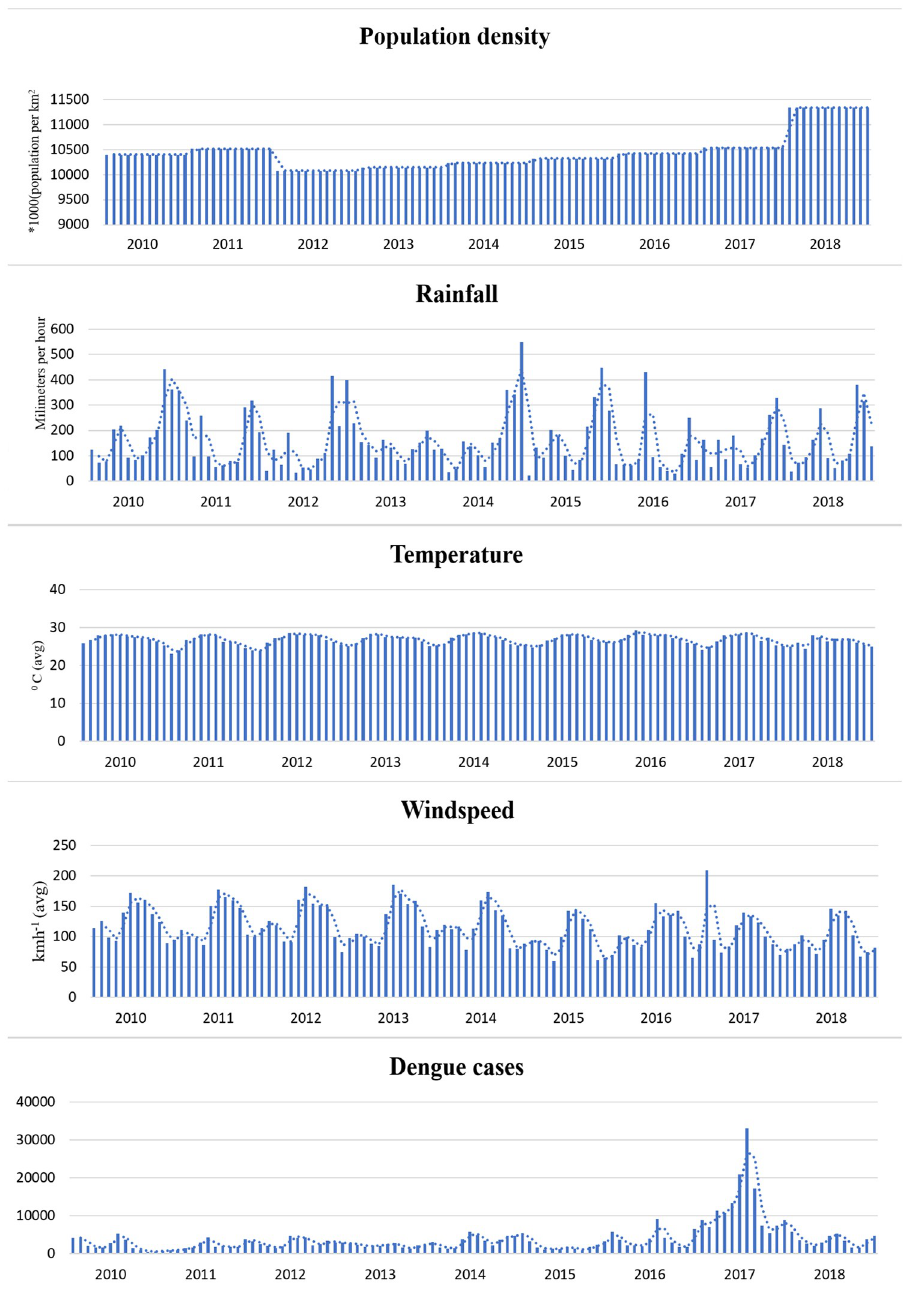
Fig 2. Architecture and the functionality of the LSTM